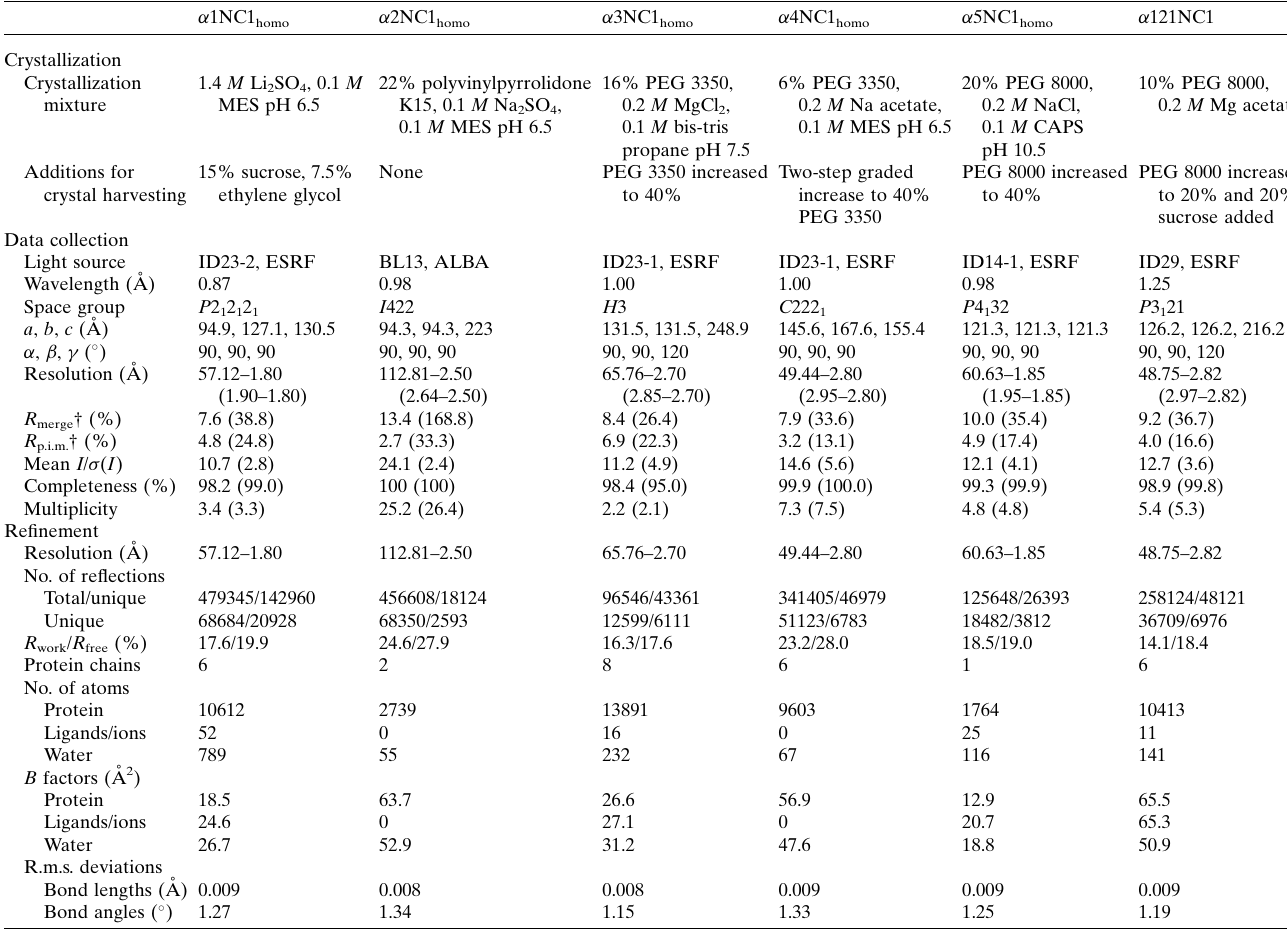
Table 1 Crystallographic data and refinement statistics for crystals of recombinant NC1 chains and their mixtures. Values in parentheses are for the highest resolution